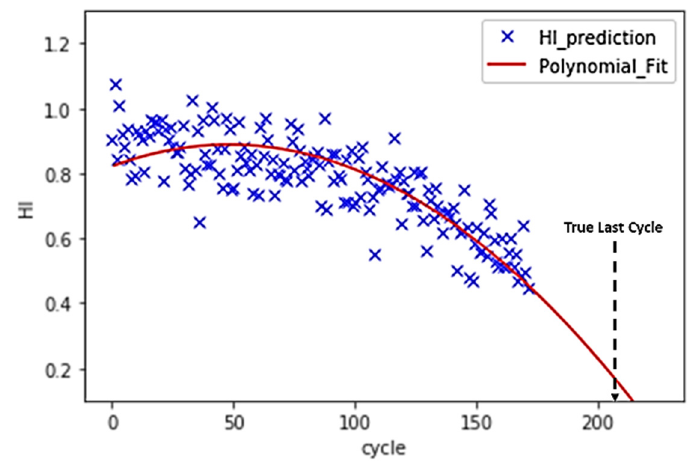
Figure 13. FD001_Test turbo unit 85 (34 cycles) test data validation.